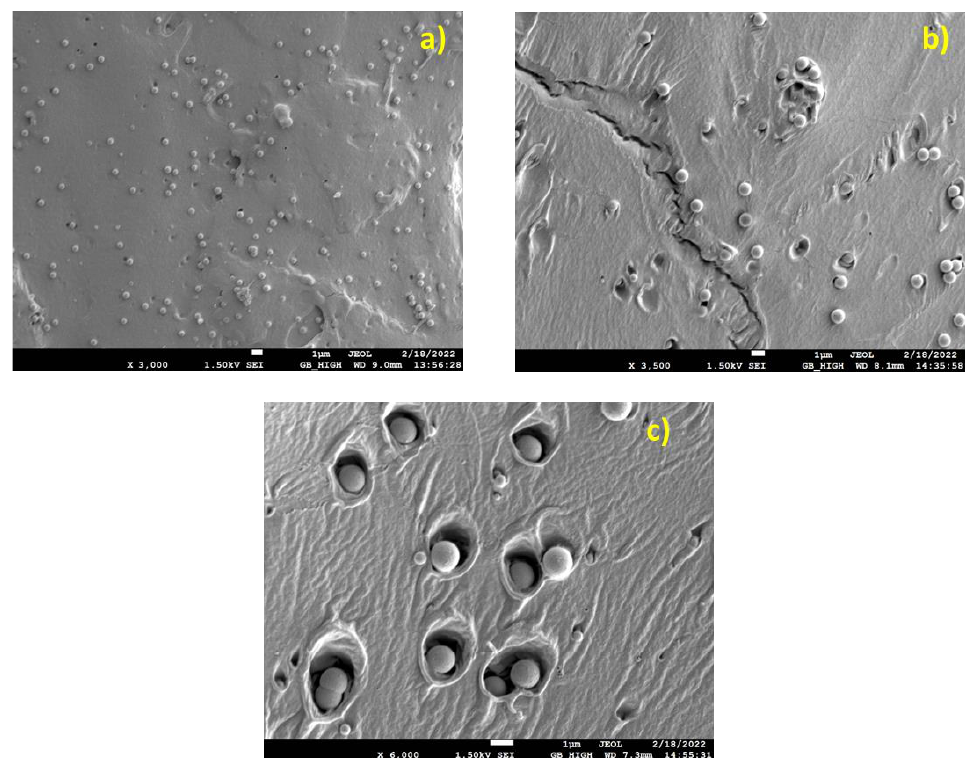
Figure 1. SEM micrographs of PLA/SiO 2 micro-composites, ( a ) PLA/0.5, ( b ) PLA/1.0, ( c ) PLA/1.5.